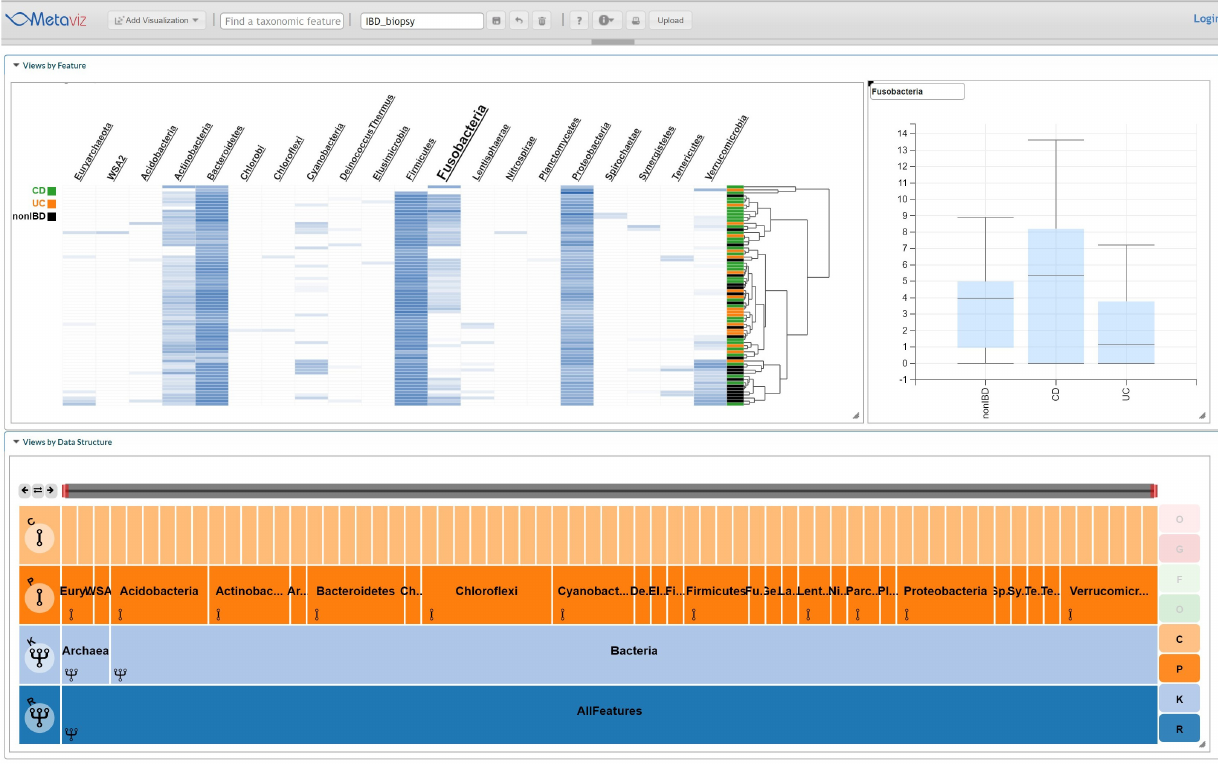
Figure 4. IBD Biopsy iHMP Multiple Groups Analysis. Using statistical analysis we identified taxonomic features that showed a difference in abundance between the three subject diagnosis categories: UC, CD, or nonIBD in the Fusobacteria phylum. This Metaviz workspace is available at: http://metaviz.cbcb.umd.edu/?ws=wHsHT56U8R